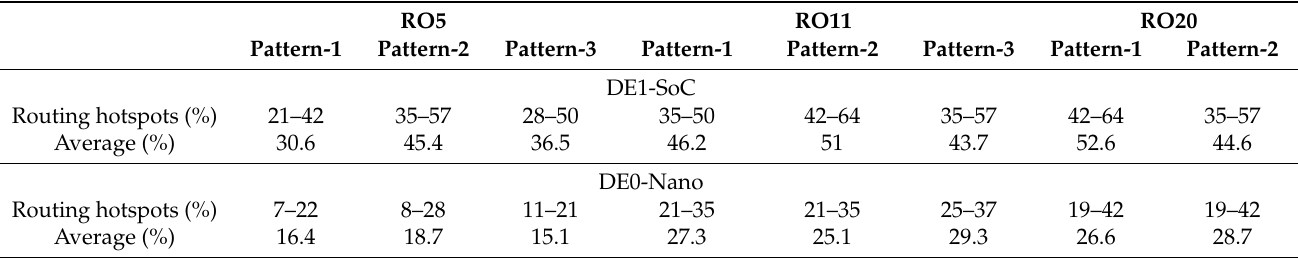
Table 2. RO routing hotspots of all patterns in DE1-SoC and DE0-Nano.